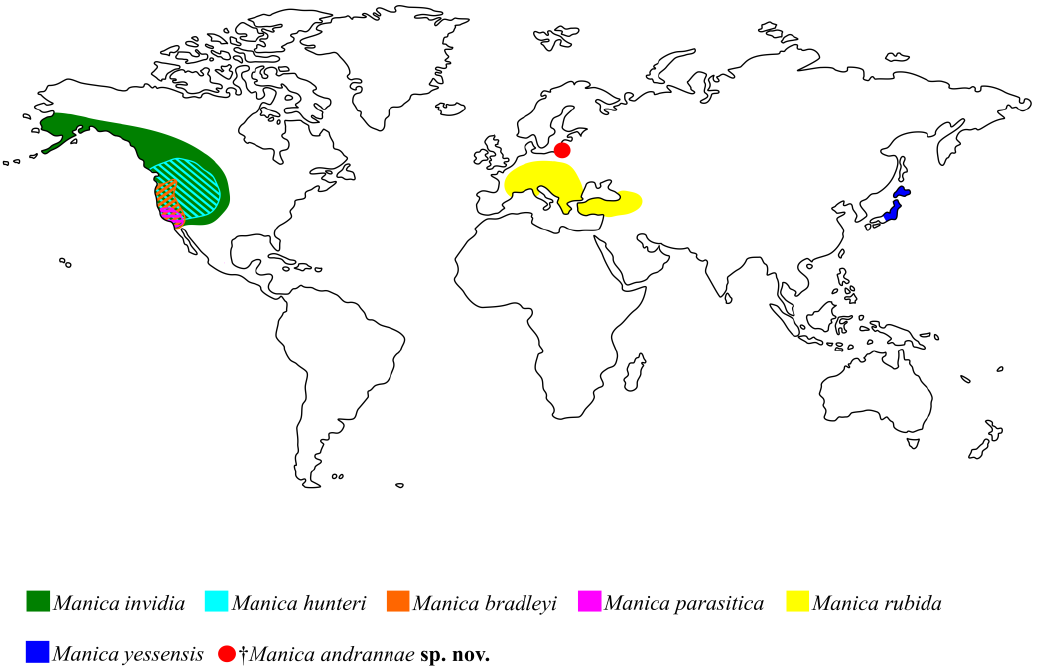
Figure 4. Diagrammatic representation of the distribution of the Manica species: filled and shaded area—recent species; red circle—fossil record from Baltic amber.